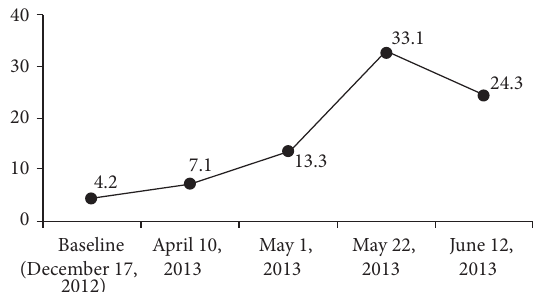
Figure 1: Change in carcinoembryonic antigen level